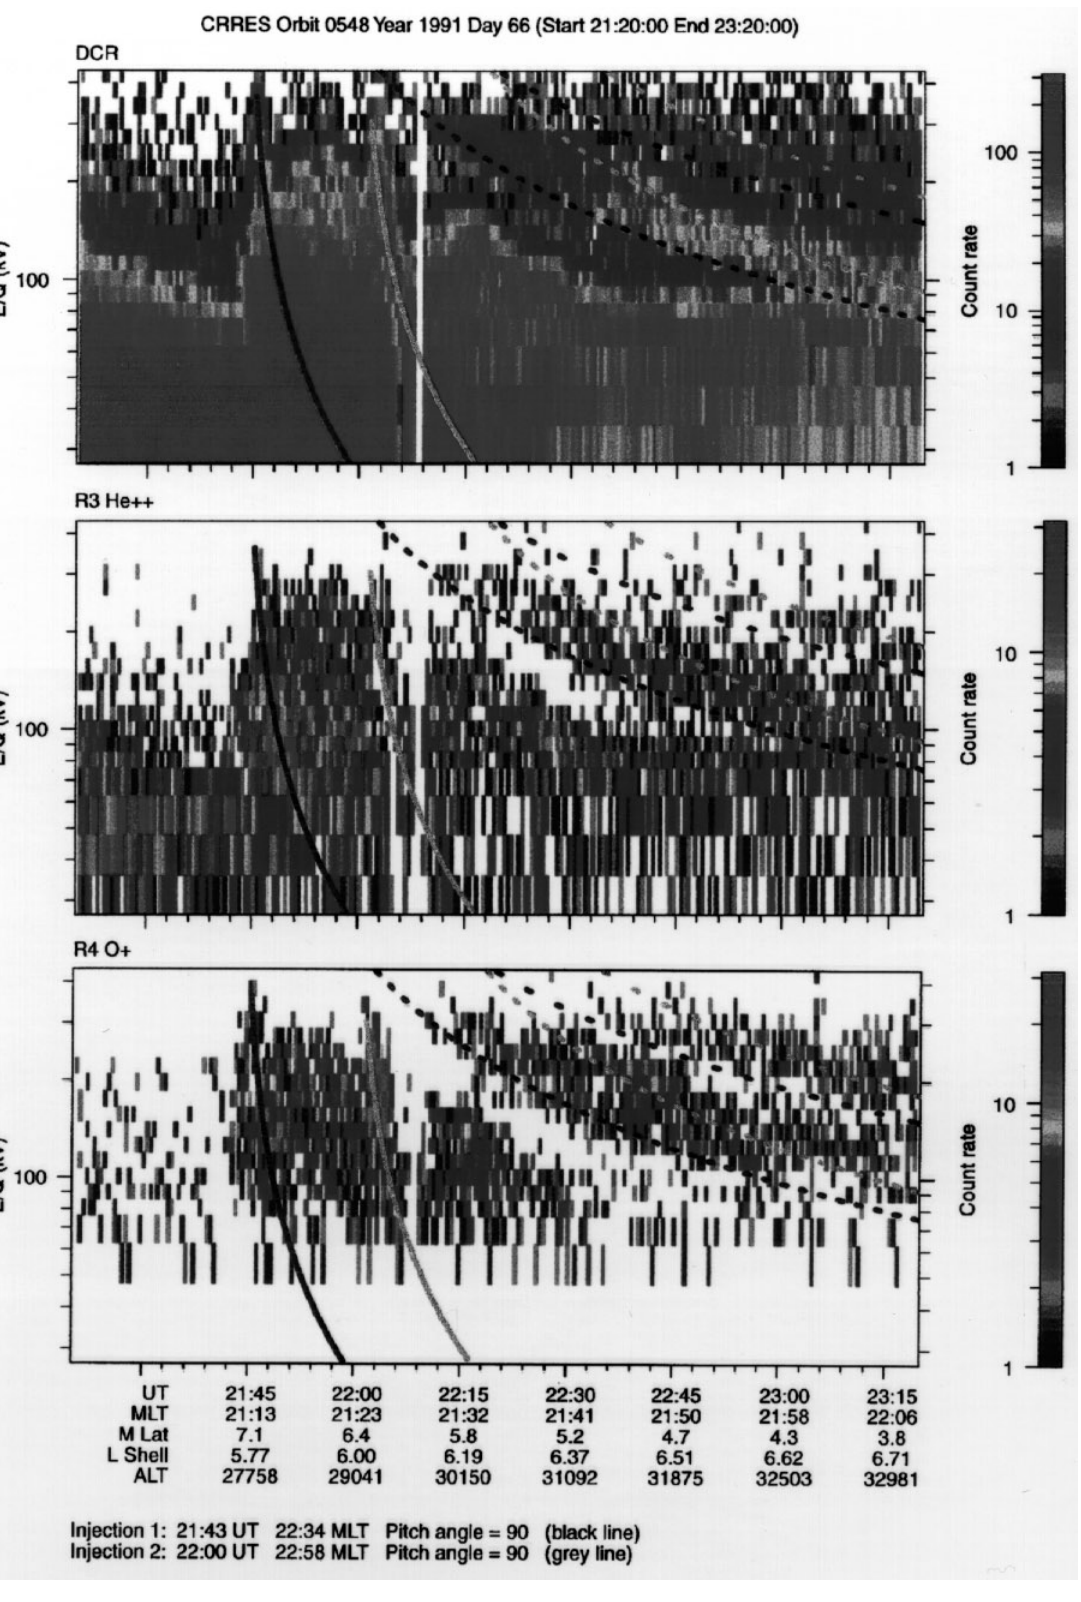
21 (cid:52)(cid:51) UT. The grey lines are simulated injection signatures for the O (cid:96) -rich injection at 22 (cid:48)(cid:48) UT which followed it. Note the instrumen- tal cutoff at low energy in the third panel (O